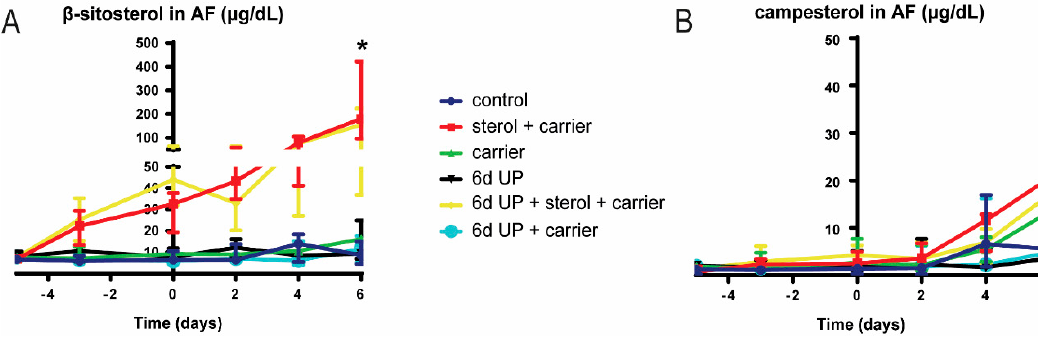
Figure 5. AF concentrations of β -sitosterol and campesterol. AF samples were taken every two days from 122 d GA until preterm delivery at 133 d GA. ( A ) AF concentrations of β -sitosterol were significantly increased at day 11 in the sterol + carrier group. ( B ) AF concentrations of campesterol tended to be increased at day 11 in the sterol + carrier group. Day 0 (122 d GA) is the start of plant sterol treatment, day 5 (127 d GA) is the day of intra-amniotic UP injection, and day 11 (133 d GA) is the moment of preterm delivery. * p < 0.05; # 0.05 < p < 0.10. Abbreviations: AF, amniotic fluid; GA, gestational age; UP, U. parvum .